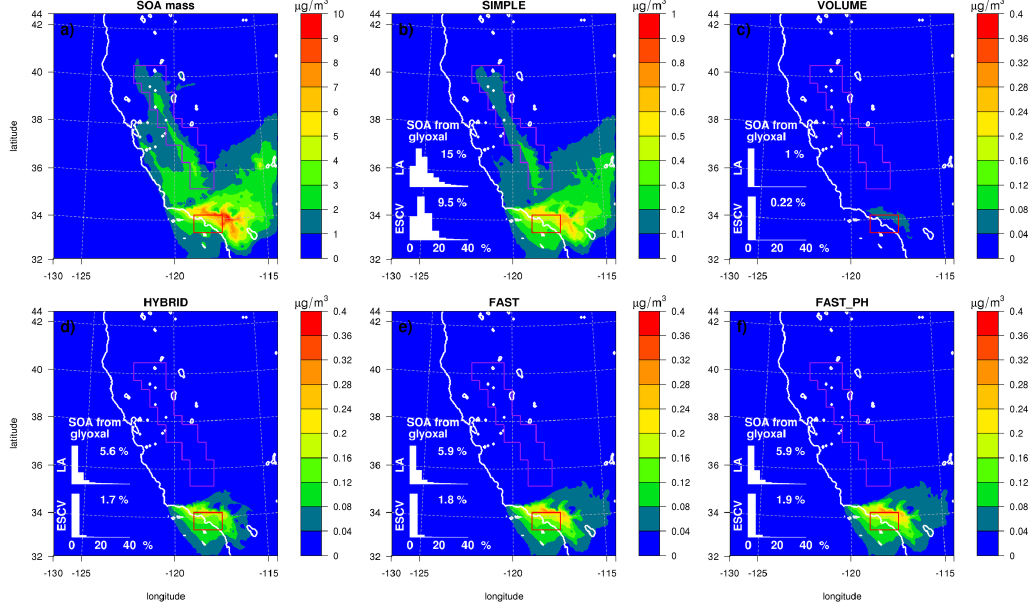
Figure 10. Average total SOA (BASE simulation, top left panel) and glyoxal-SOA masses (all other panels) in the lowest model vertical layer for the different studies. Note the differing scales. For each study, a histogram of the relative mass contribution of glyoxal to total SOA mass in the LA (red outline) and ESCV (purple) focus regions, as well as the average, is shown in the lower left corner of each panel. Histograms are based on the percent contribution of glyoxal SOA to total SOA for all grid points in the focus region at every hour of the simulation